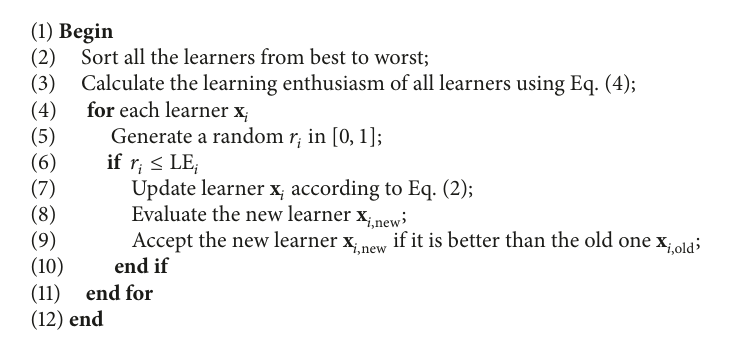
Algorithm 3: Learning enthusiasm based learner